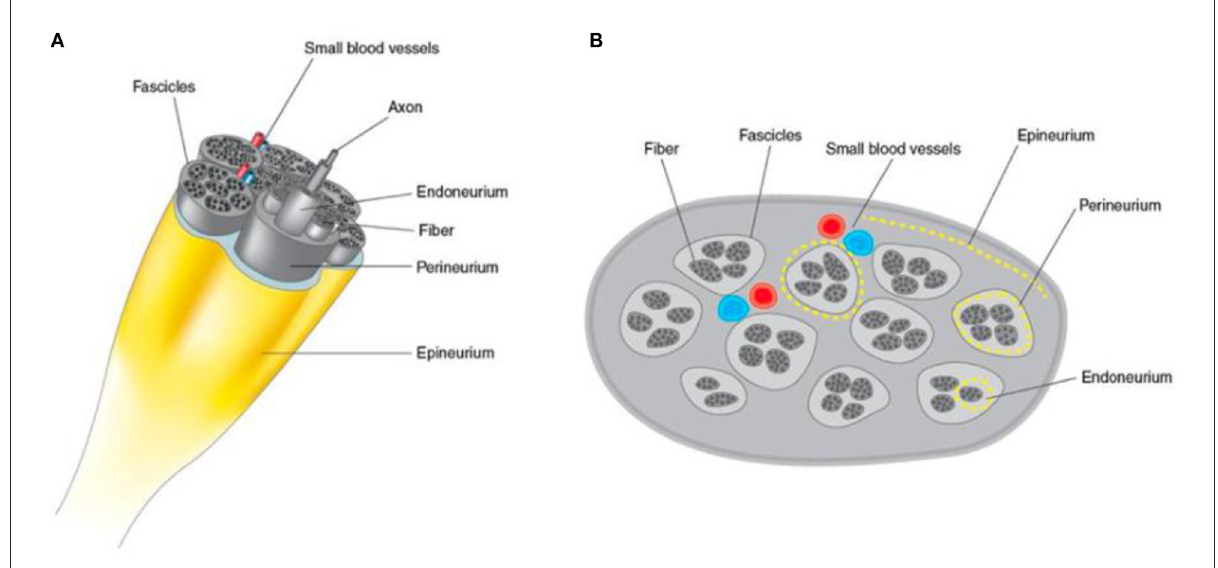
FIGURE1 Schematic representation of the cross-sectional view of a normal peripheral nerve and its morphological structures obtained by HRUS. (A) 3D view and (B) with a honeycomb